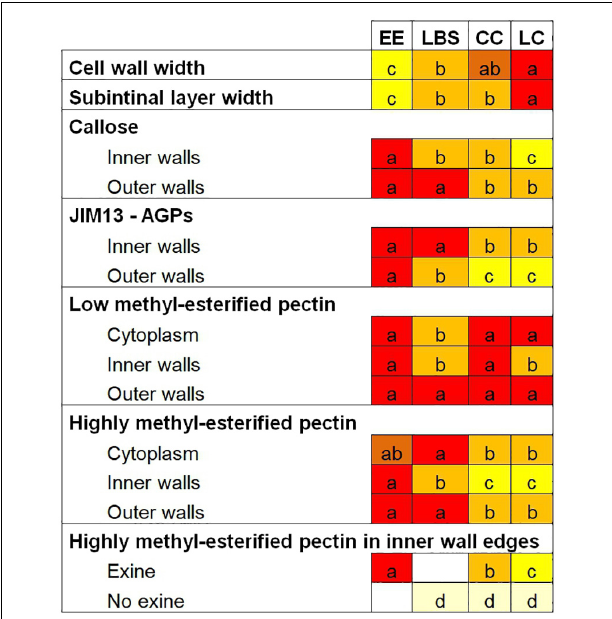
FIGURE 9 | Summary of the cell wall composition characteristics of the different embryogenic microspore-derived structures. Different letters represent statistically significant differences in labeling density according to the LSD test, ranging from a (the highest labeling density) to d (the lowest labeling density). For a better comparison among structures, each letter is associated with a different background